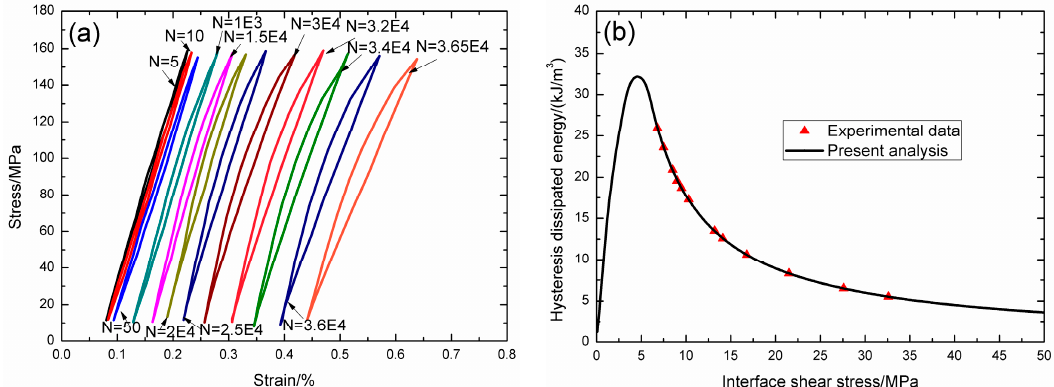
Figure 15. ( a ) The experimental fatigue hysteresis loops corresponding to different cycle number; and ( b ) the experimental and theoretical fatigue hysteresis dissipated energy versus interface shear stress curve of 2D woven SiC/SiC composite under σ max = 150 MPa at 800 °C in air. Table 10. The interface shear stress of 2D woven SiC/SiC composite corresponding to different applied cycles under fatigue peak stress of σ max = 150 MPa at 800 °C in air.